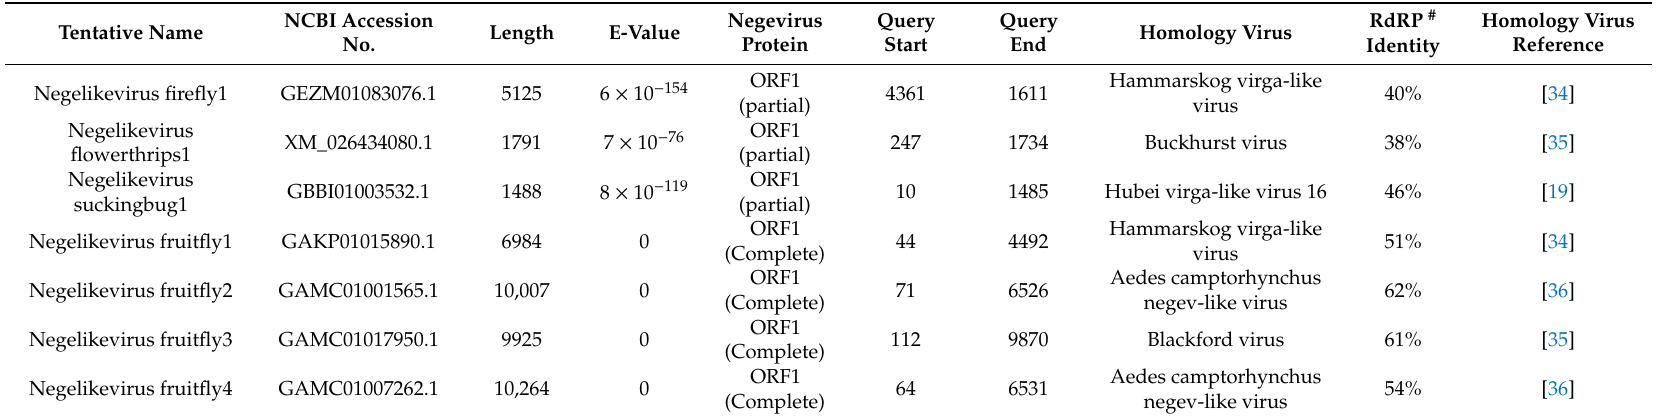
Table 1. Negevirus-like Contigs identified in other insects from the public